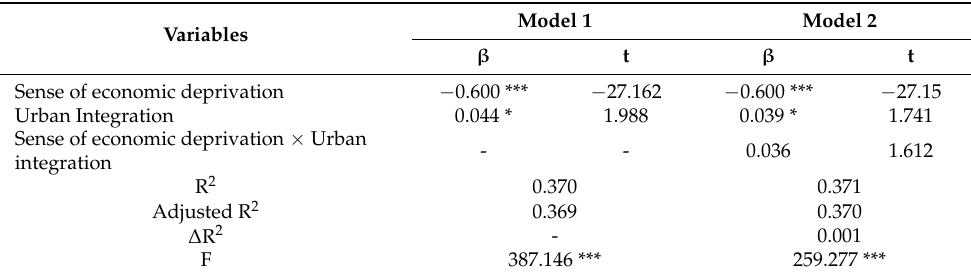
Table 10. Test of the moderating effect of urban integration between perception of social deprivation and social